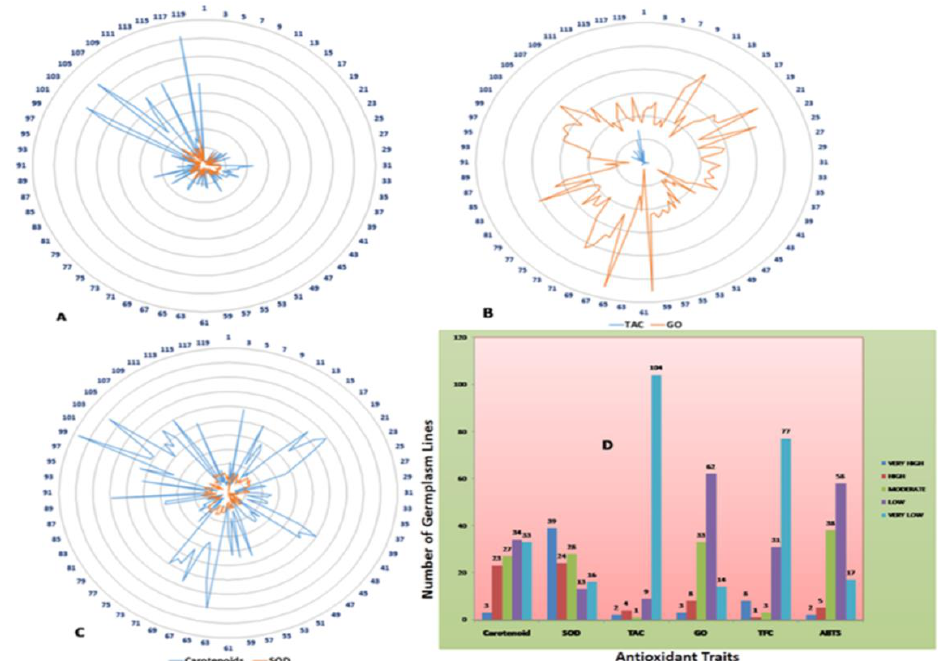
Figure 2. Estimate of 6 antioxidant traits in the 120 genotypes and their frequency distribution in the panel population. ( A ) Spider graph showing TFC content and ABTS activity. ( B ) TAC and γ -oryzanol content; ( C ) Carotenoid and SOD content; ( D ) Frequency distribution of germplasm lines for carotenoids, superoxide dismutase, anthocyanins, γ -oryzanol, flavonoids, and ABTS in the panel